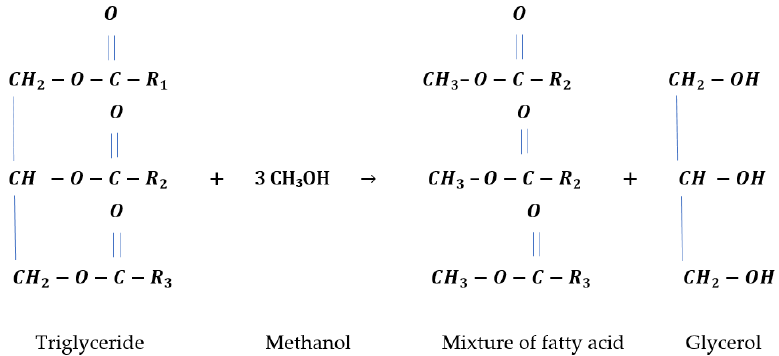
Figure 2. Transesterification of waste cooking oil.